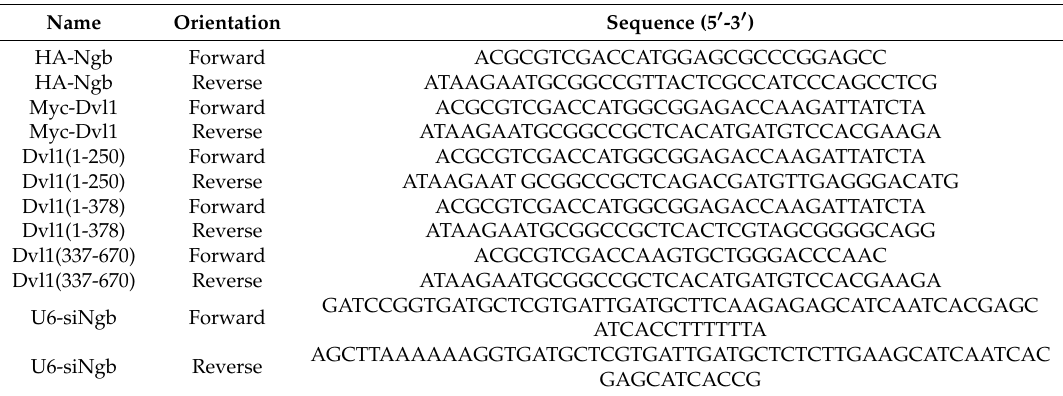
Table 1. Primers used in the present